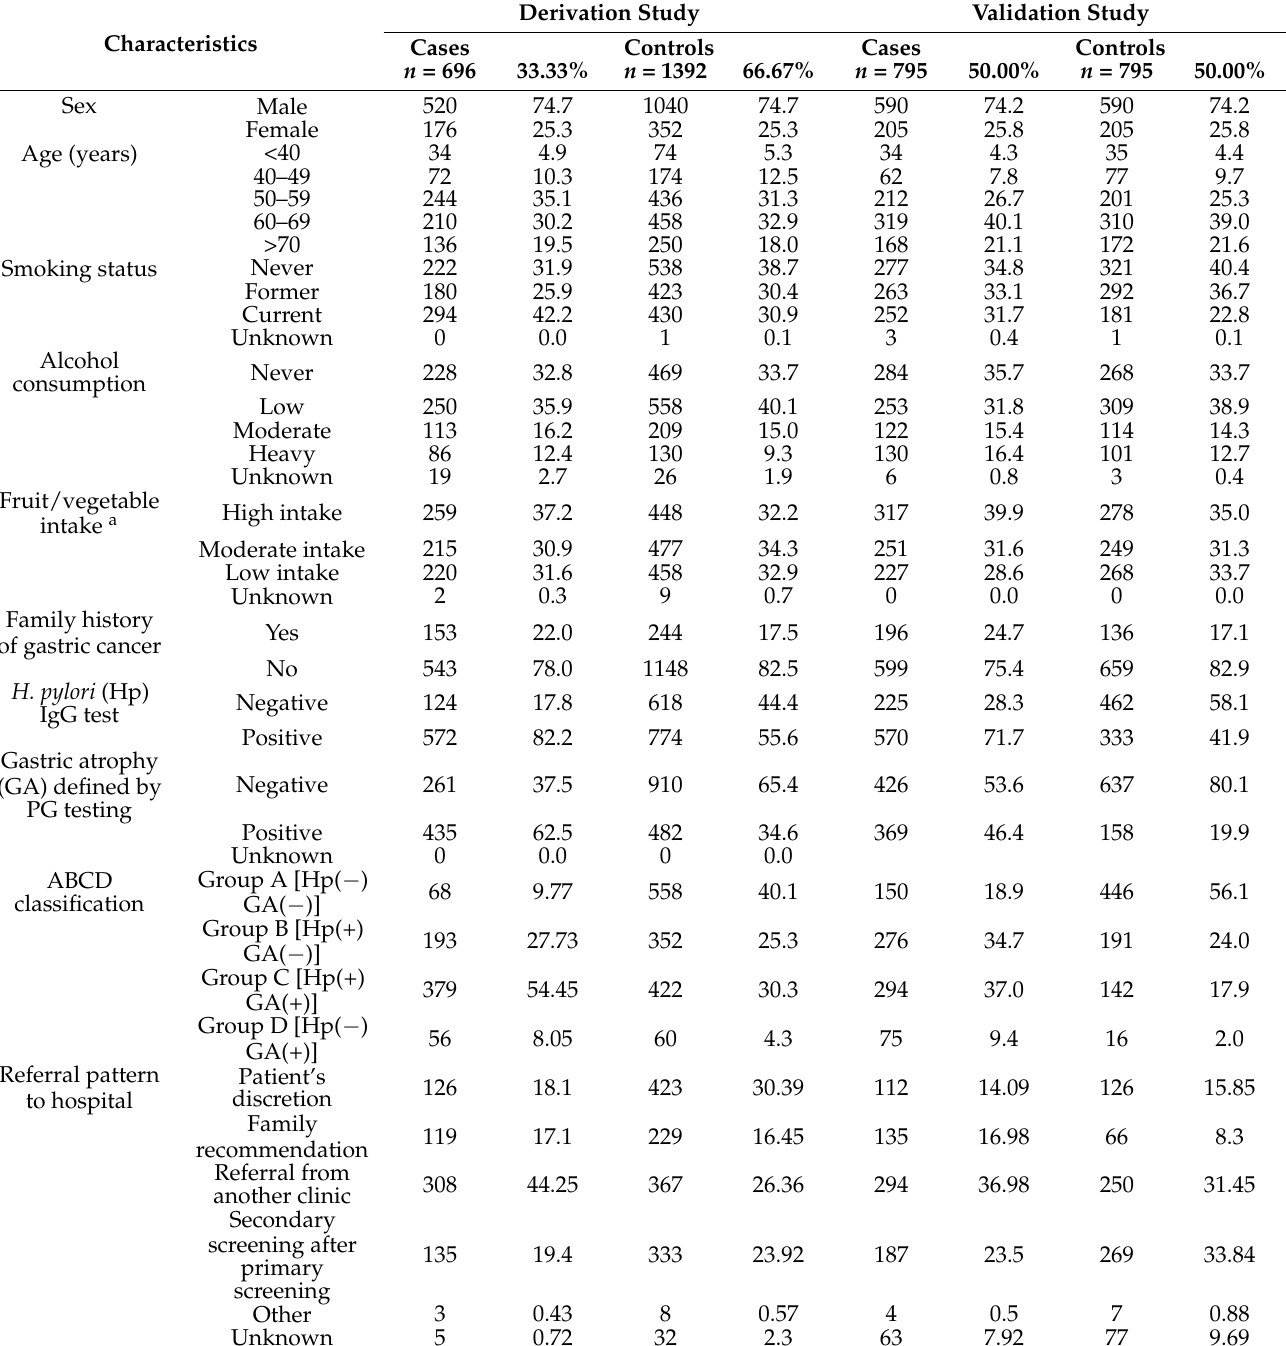
Table 1. Characteristics of